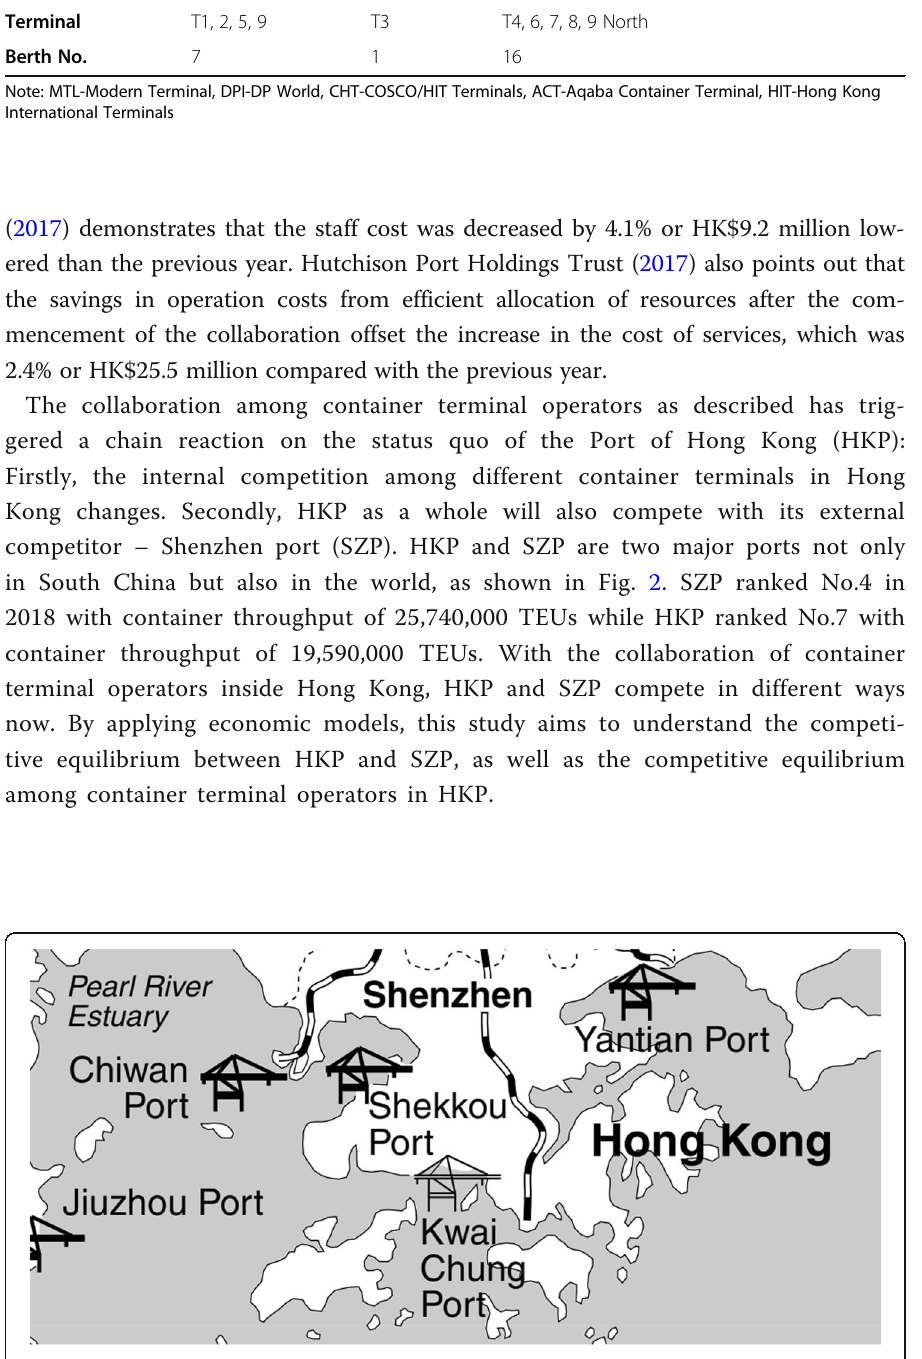
Table 1 Hong Kong Container Terminal Operators Association, 2018, before & after collaboration Operator MTL DPI CHT ACT HIT Before Terminal T1, 2, 5, 9 T3 T8 east Berth No.